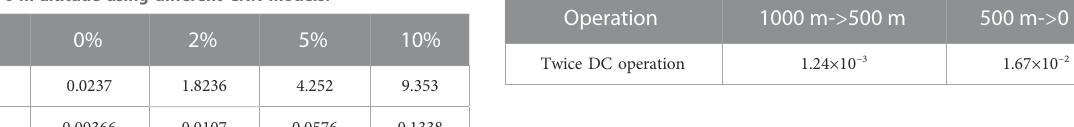
TABLE 3 MSE of errors between the predicted gravity anomaly and the true gravity anomaly at 0 m altitude using different CNN models.